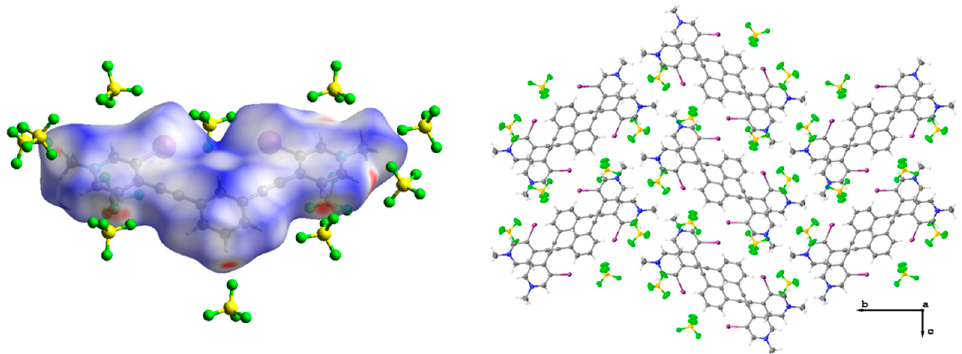
Figure 2. Hirshfeld surface map of 1 highlighting the C-H hydrogen bonding contacts and arrangement of tetrafluoroborate anions around the receptor ( left ). Packing diagram of 1 when viewed down the crystallographic a axis, highlighting the herringbone arrangement of dimer columns ( right ). Thermal ellipsoids are drawn at the 50% probability level and anion disorder is omitted for clarity.